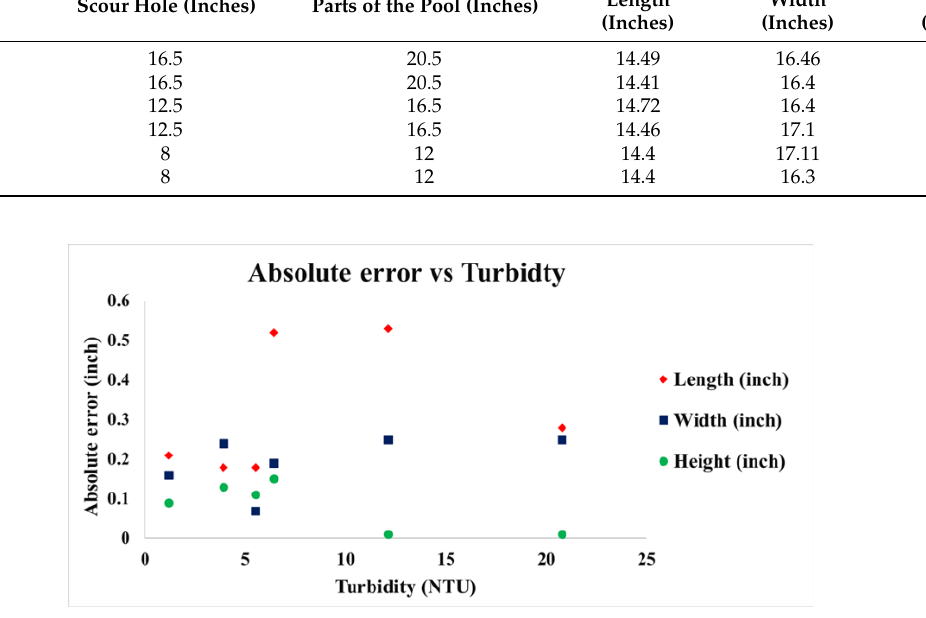
Figure 22. Effect of turbidity on the absolute error (adapted from Nagarajan & Arockiasamy, 2020a and 2020b)